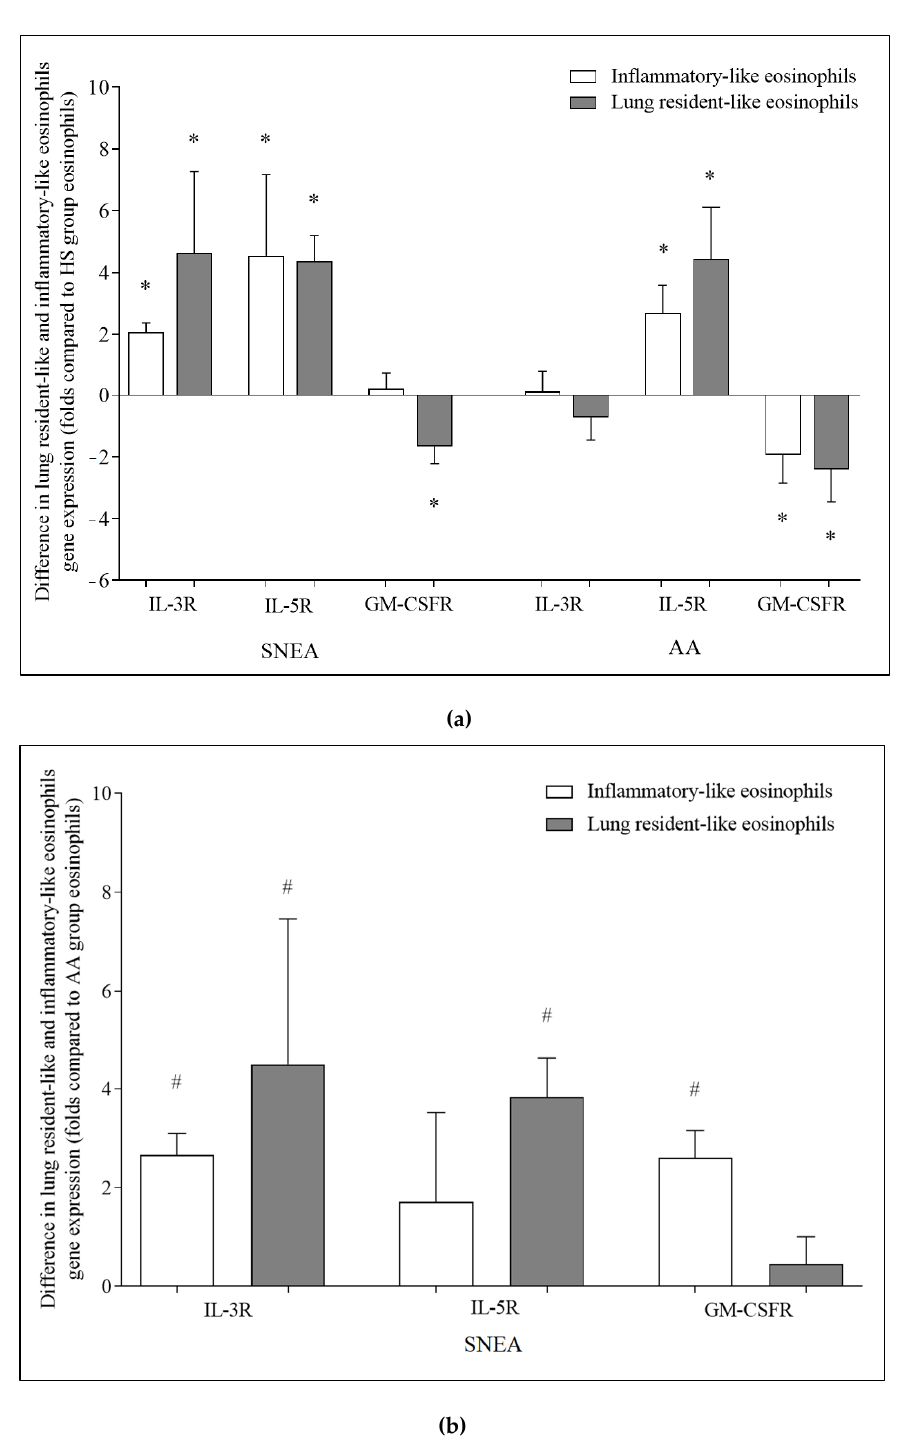
Figure 5. Differences in expression of IL-3R, IL-5R, and GM-CSFR genes between eosinophil sub- types. Comparison of ( a ) SNEA and AA groups with HS group; ( b ) SNEA group with AA group. IL-3R—interleukin 3 receptor; IL-5R—interleukin 5 receptor; GM-CSFR—granulocyte-macrophage colony-stimulating factor receptor. Severe nonallergic eosinophilic asthma (SNEA) group n = 10, nonsevere allergic asthma (AA) group n = 8, healthy subjects (HS) group n = 11. Data presented